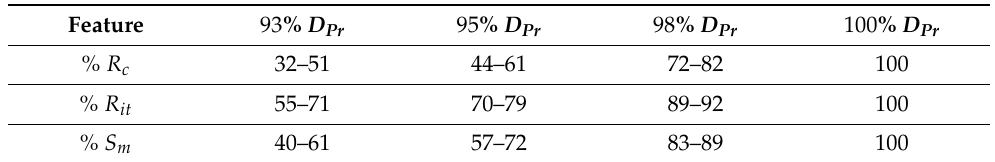
Table 6. Percentage values of the parameters under different compaction ratios in relation to values at 100% D Pr .